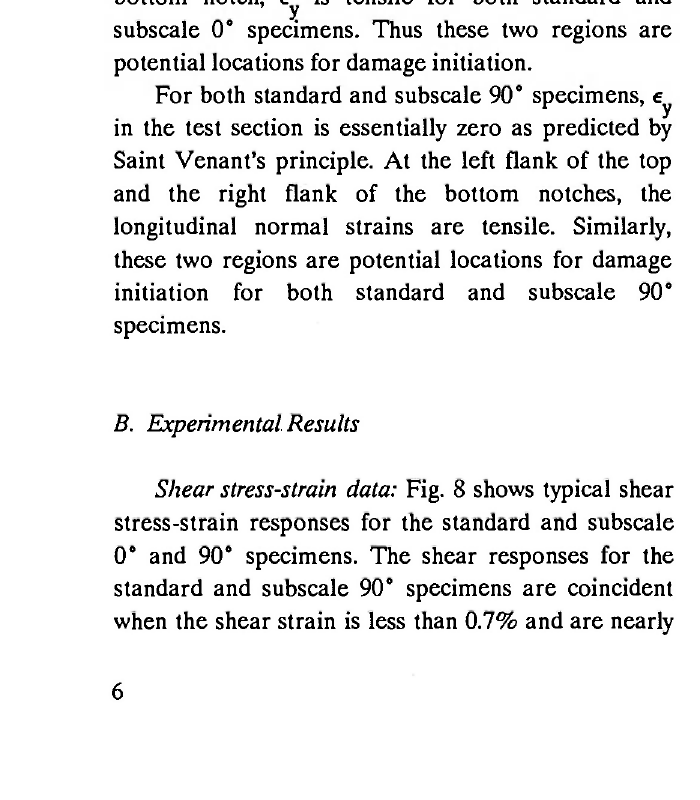
Fig. 7: (a) Longitudinal normal strain, (b) shear strain contours of the subscale 90° specimen.